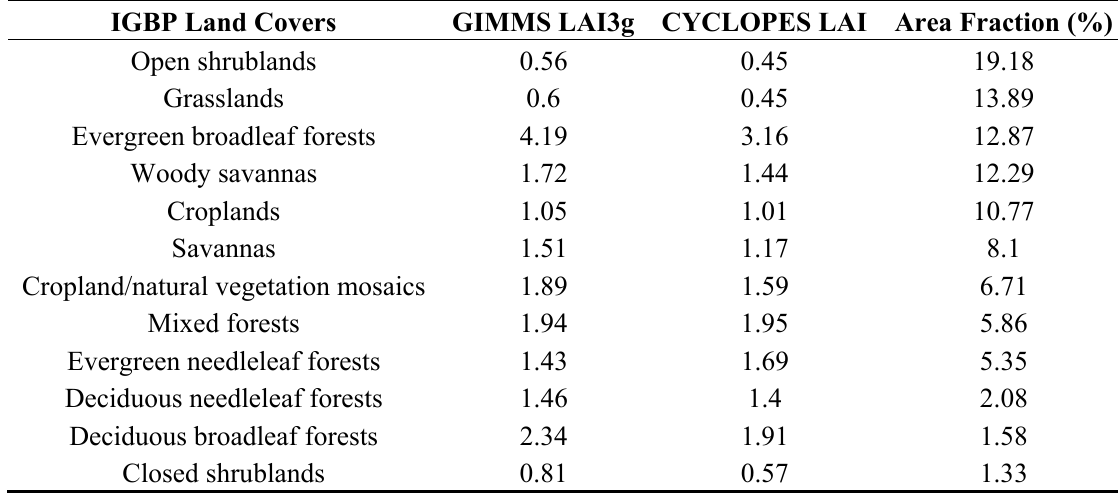
Table 1. Comparison of annual mean values of LAI3g and CYCLOPES LAI for different IGBP land covers. The table is sorted by descending order of the area fraction of the land covers. The data are averages for the years 1999 to